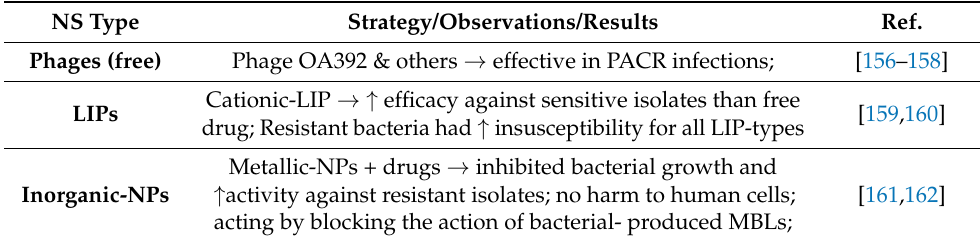
Table 6. Nanosystems for treatment of PACR